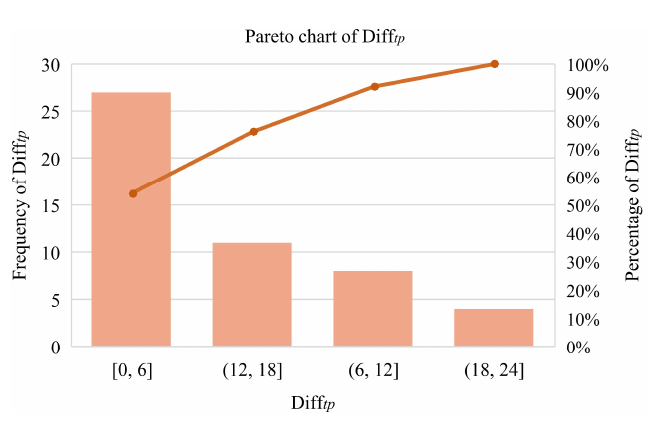
Figure 11. Pareto chart of Diff tp of the fitted curve N a = P 3 ( C )